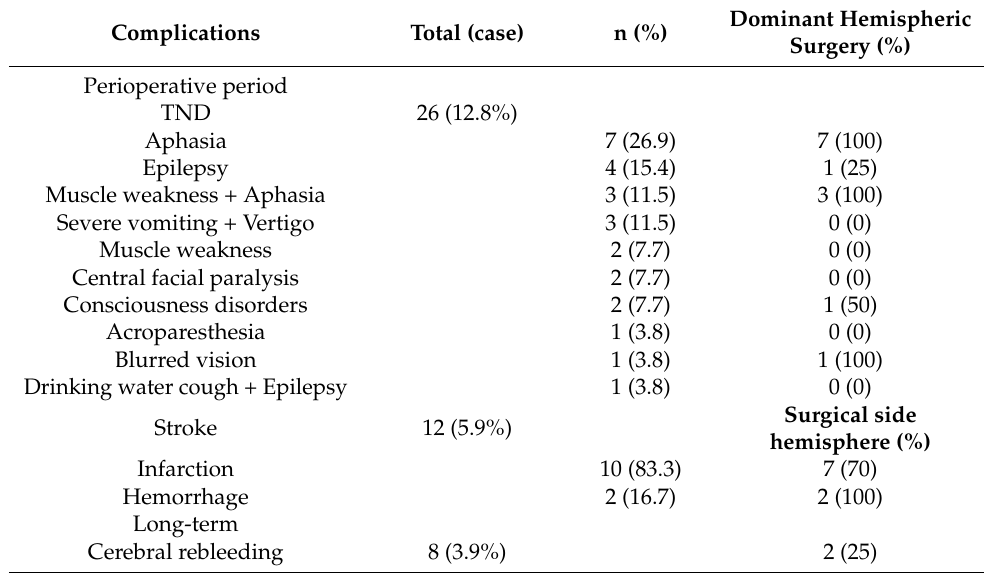
Table 3. Summary of 46 cases of Postoperative